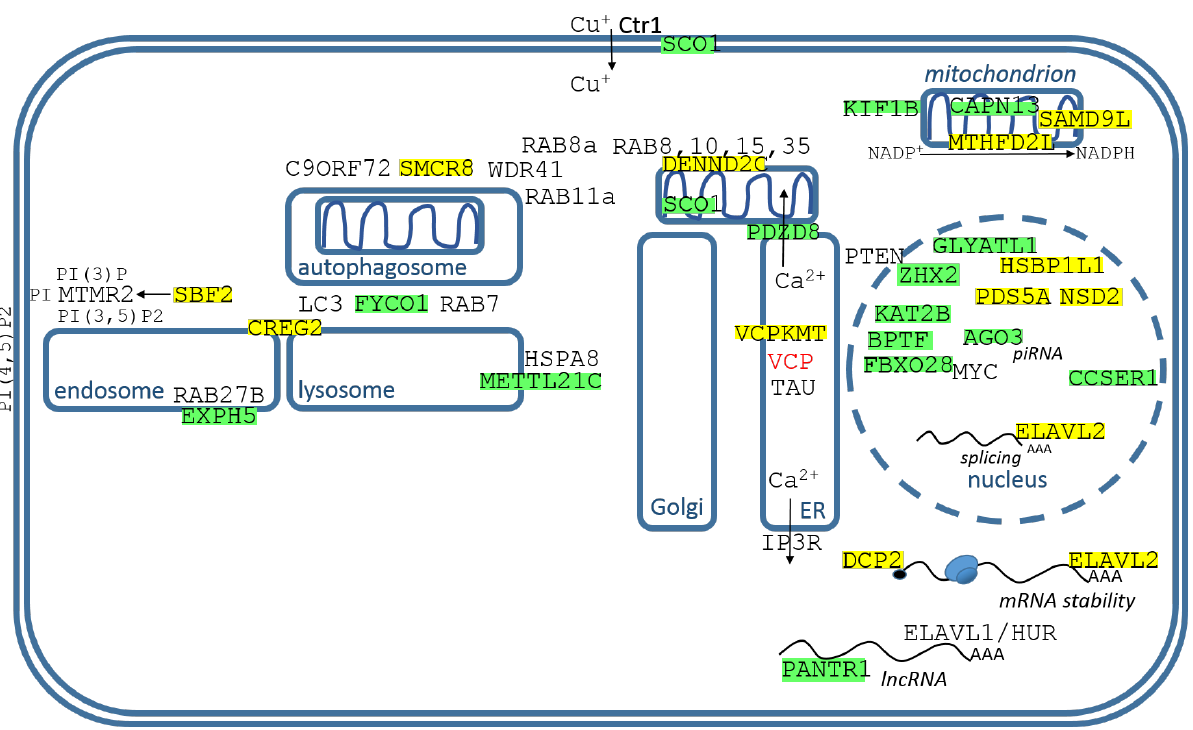
Figure 5. Identified genes/proteins with functions in membrane organelles, mitochondria, and nucleus. The descriptions of genes/proteins are given in the text, from endosomes to nucleus, from left to right. Green highlights show alignments with the complement sequence (post-transcriptionally repressed), yellow highlights show alignments with the reverse complement sequence (post- transcriptionally